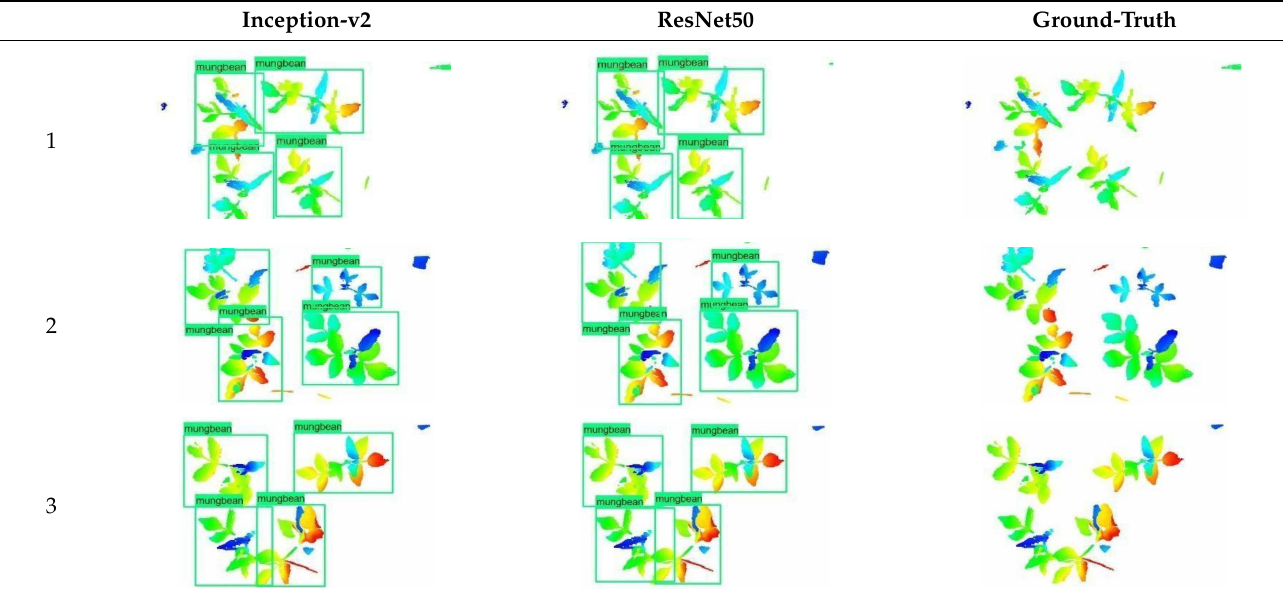
Table 3. Faster RCNN Inception-v2 and Faster RCNN ResNet50 models produced mung bean and chickpea detection results for randomly selected eight test images and their original